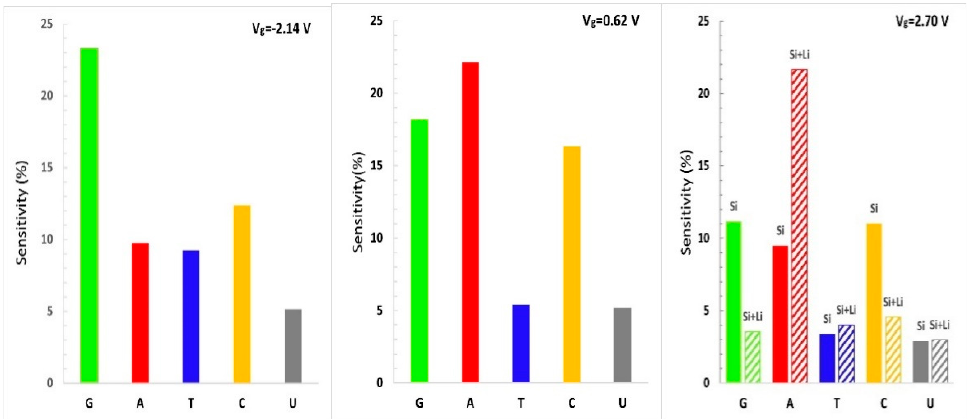
Figure 8. For different gate voltages (left panel V g = − 2.14 V and middle panel V g = 0.62V), the calculated sensitivity histogram of the theoretical silicene sequencing biosensor with five different nucleobases is plotted. For the gate voltage V g = 2.70 V (right panel), we compared the sensitivity histogram of the nucleobases on bare silicene (Si stands for silicene) and Li ‐ supported silicene (Si + Li stands for Li ‐ supported silicene).